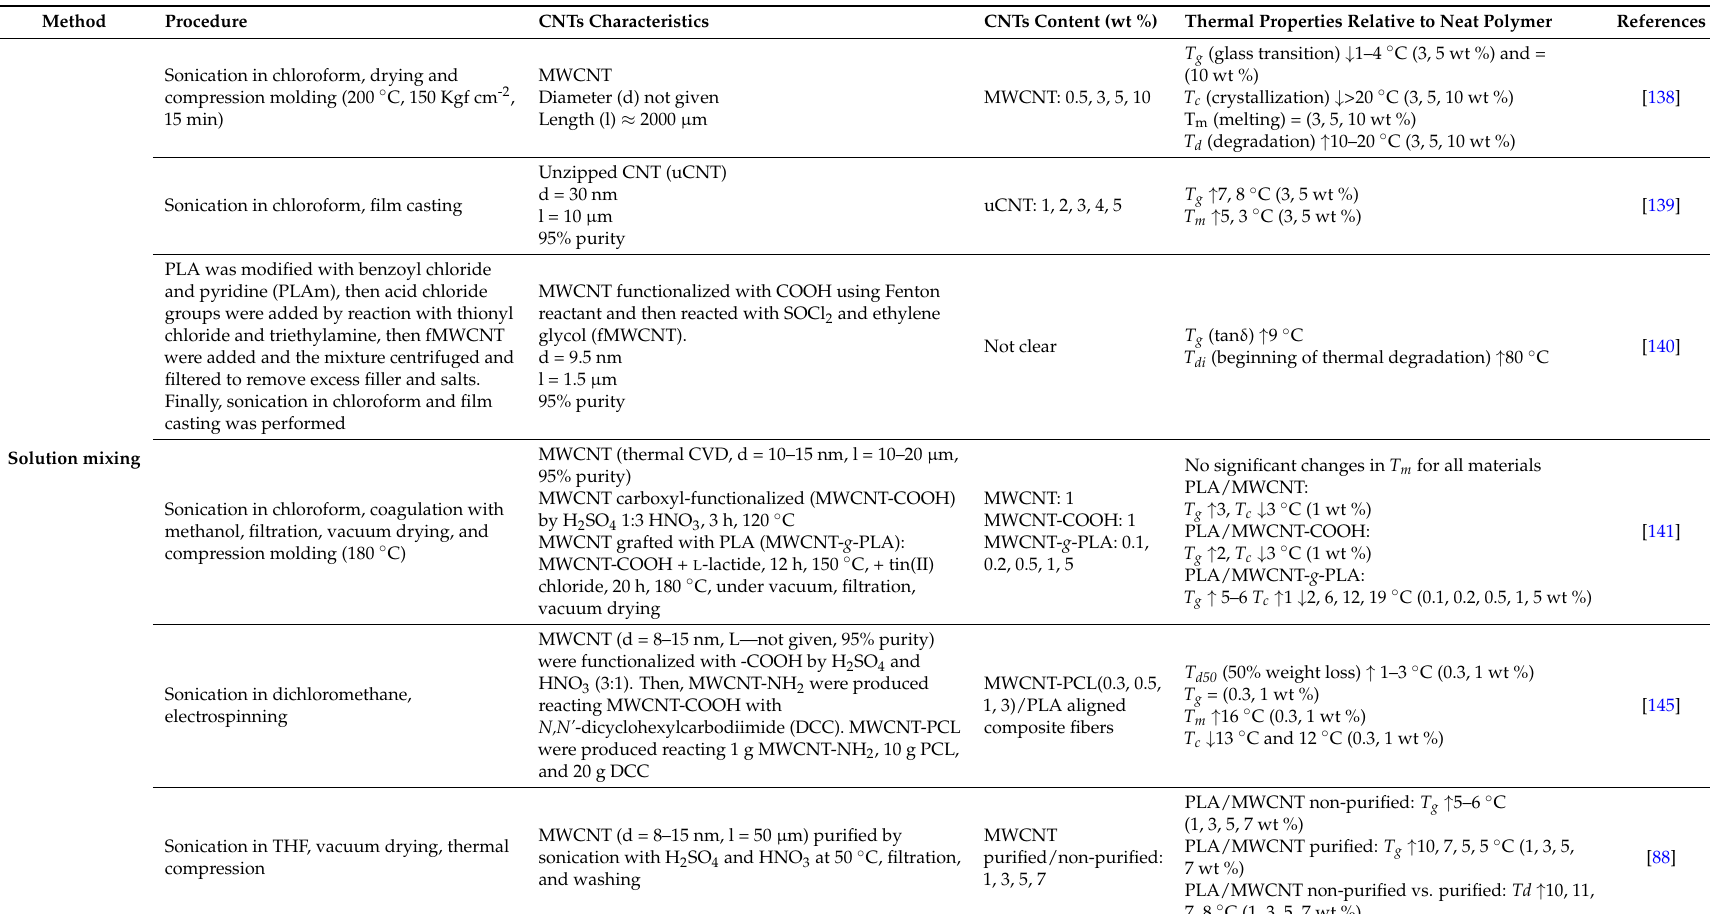
Table 3. Thermal properties of PLA/CBN composites in comparison with non-modified PLA. Production methods and CBN characteristics.